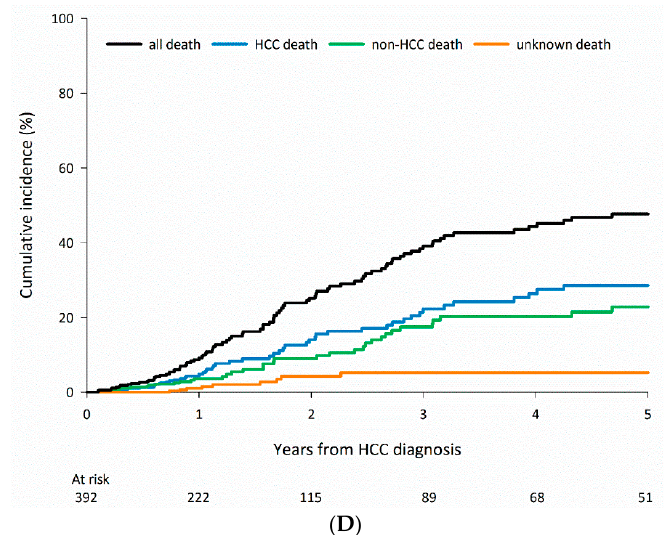
( D ) 10 of 18 Figure 2. Cumulative mortality risk for hepatocellular carcinoma among patients who received curative treatments according to chronic liver disease etiology: ( A ) hepatitis C virus; ( B ) hepatitis B virus; ( C ) alcohol use; and ( D ) all negative (defined as no evidence of virus infection or alcohol use). (Figure 3D). By contrast, HCC-related mortality and non-HCC-related mortality were similar in the alcohol-related group (Figure 3C). Table 3. Cause-specific mortality among patients who underwent curative treatment.